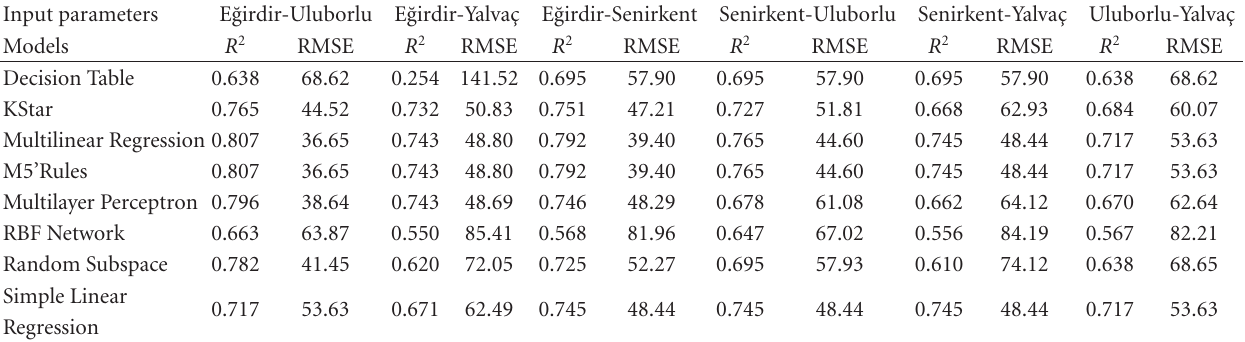
Table 2: The performance criteria of the models having 2-input parameters.